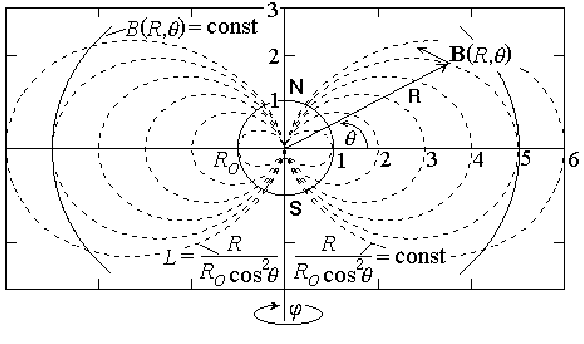
Fig.1. Dipole magnetic field configuration for the inner Earth’s magnetosphere. Fig. 1. Dipole magnetic field configuration for the inner Earth’s